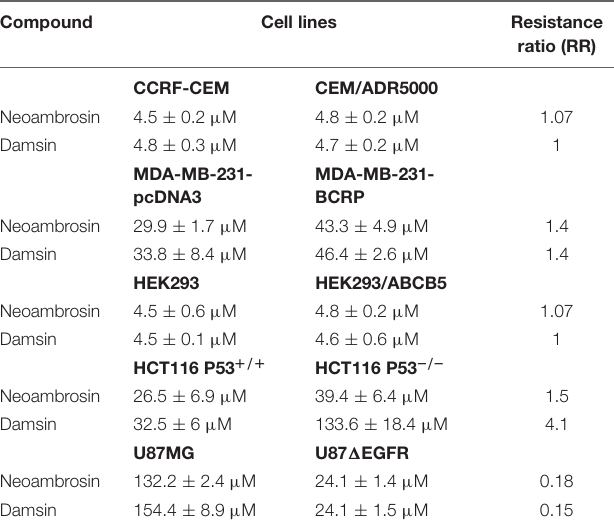
TABLE 1 | IC 50 values of different drug-sensitive and -resistant cell lines of neoambrosin (1) and damsin (2). Compound Cell